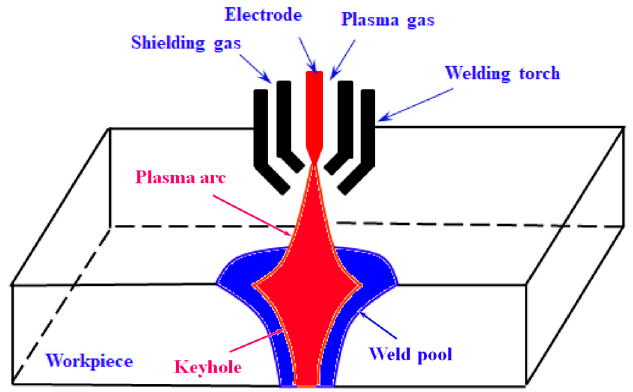
Figure 1. A keyhole-mode plasma arc welding.